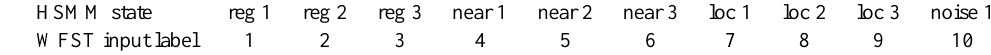
Table 1. The mapping of HSMM states and WFST input labels. Each earthquake class has three states.